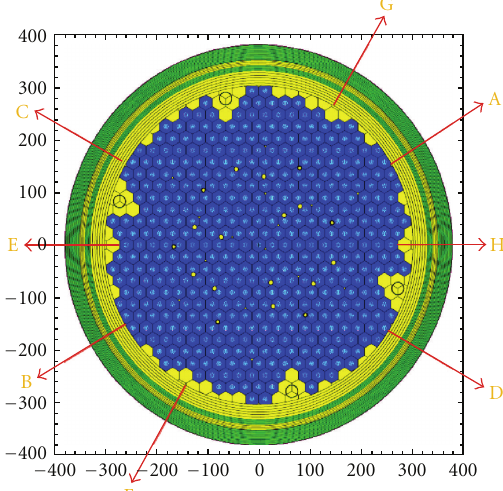
Figure 4: x - y view of the reactor for Z = 0 . 0cm.